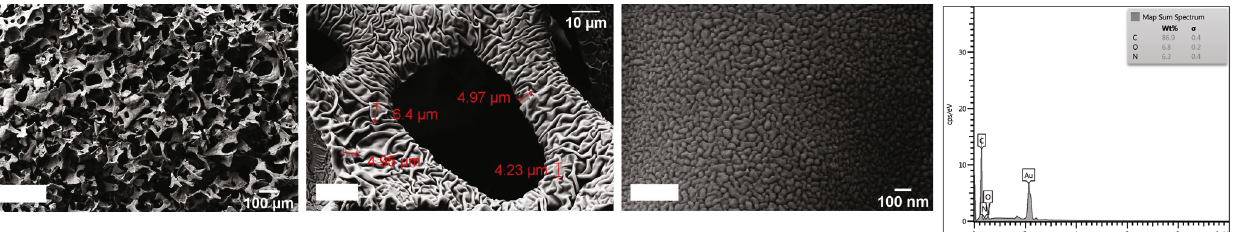
Figure 19: SEM images and energy-dispersive spectroscopy (EDS) analysis of PURFs